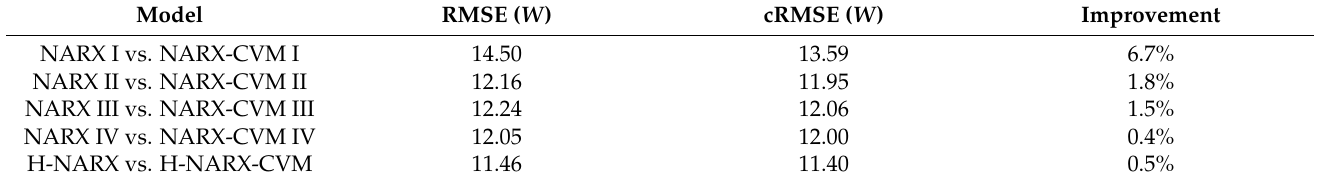
Table 10. RMSE comparison for NARX models with and without CVM.